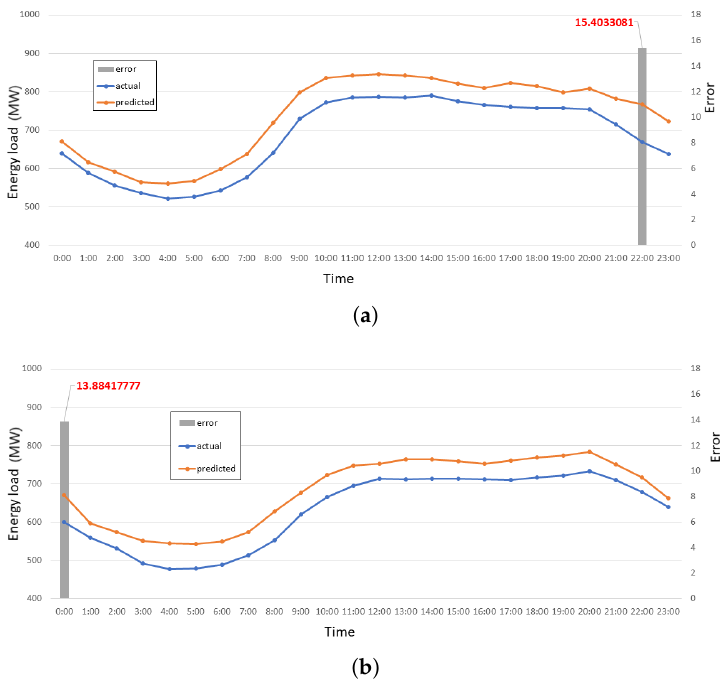
Figure 20. Highest errors recorded due to Typhoon Lingling. ( a ) First day of Typhoon Lingling;